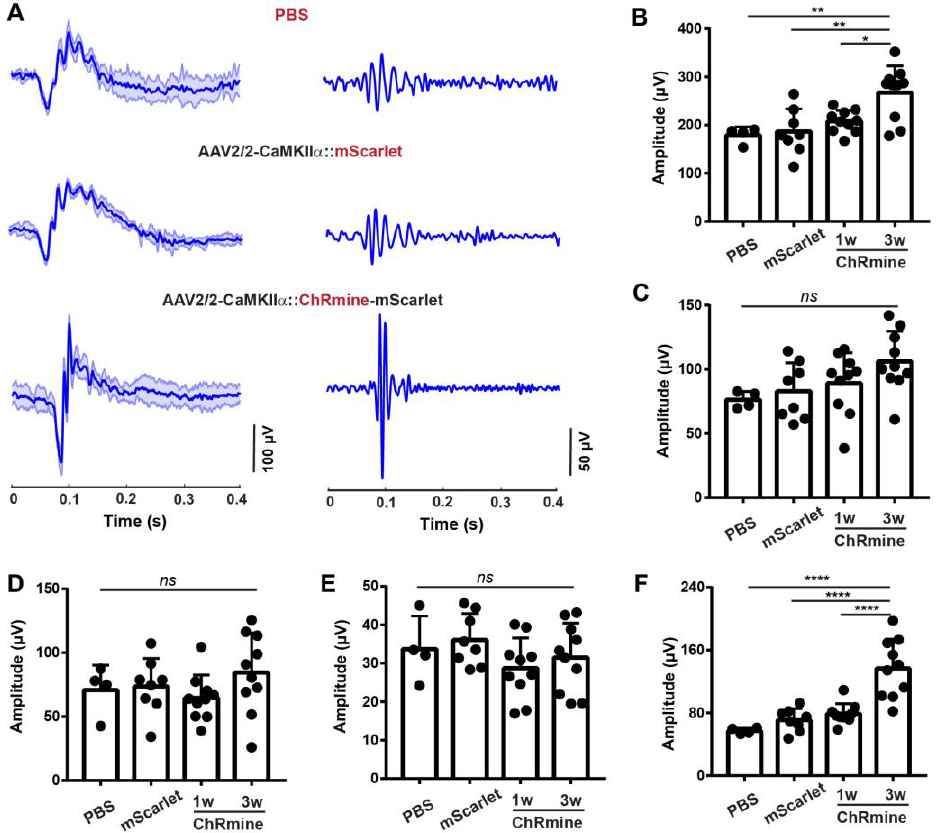
Figure 4. Scotopic flash ERG responses under optogenetic activation of RGCs. ( A ) Representative scotopic flash ERG waveforms ( left ) and OPs ( right ) under red-light stimulation. Three groups of mice are intravitreally injected with solutions of PBS, AAV2/2- CaMKIIα: mScarlet (mScarlet), and AAV2/2- CaMKIIα: ChRmine-mScarlet (ChRmine). The statistical quantification of the overall maximum response ( B ), a-wave ( C ), b-wave ( D ), NR ( E ), and OPs ( F ) of the scotopic flash ERG signals under red-light stimulations for different groups. The ERG signals in PBS and mScarlet mouse groups are collected at 2 weeks post-injection. The ERG signals in the ChRmine group are collected at 1 week (1 w) and 3 weeks (3 w) post-injection. PBS: N = 4 eyes, mScarlet: N = 8 eyes, ChRmine: N = 10 eyes. ns: not significant. * p < 0.05, ** p < 0.01, and **** p < 0.0001.